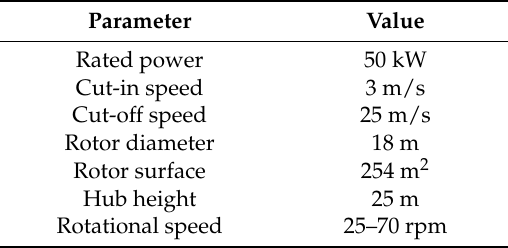
Table 2. Wind turbine data.